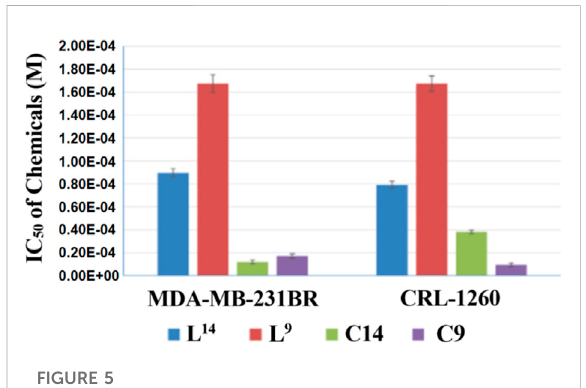
FIGURE 5 IC 50 of compounds L 14 , L 9 , C14 , and C9 . The copper(I) complexes signi fi cantly increase the anticancer activity compared with their relevant ligands.